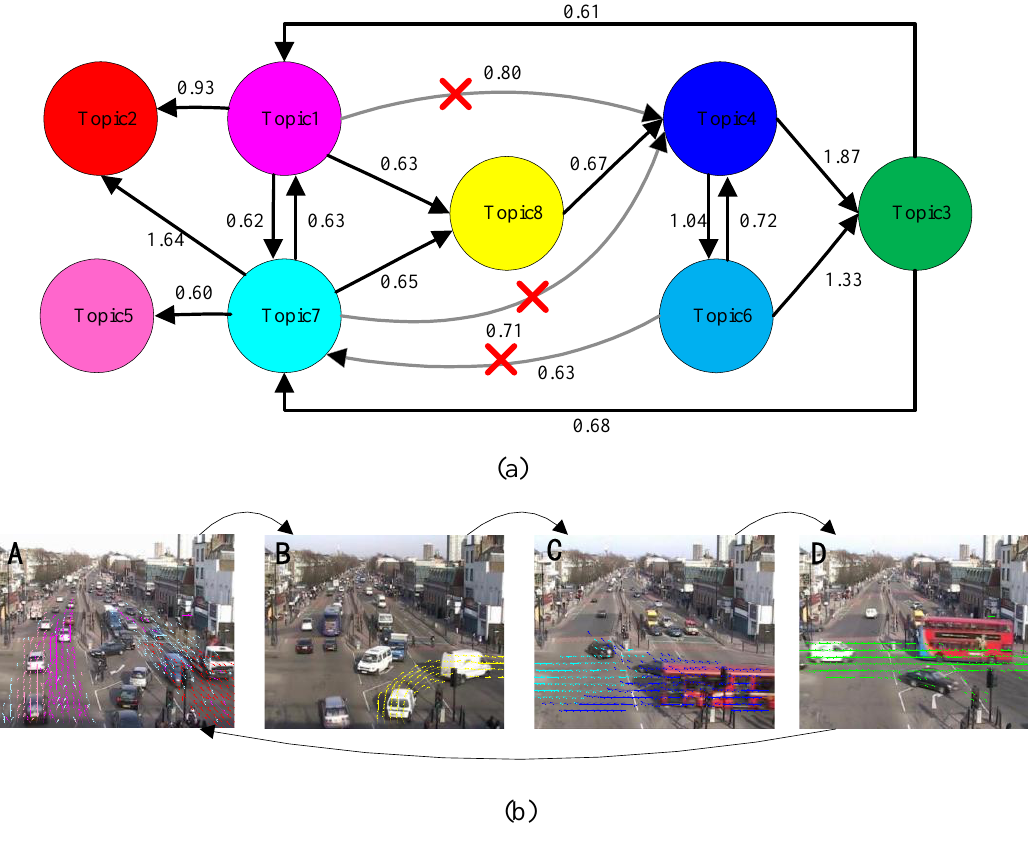
Figure 9. Granger causality approach applied to the intersection dataset. ( a ) Top: visualization of the temporal causal analysis. The connection between topic 6 and topic 7 is spurious because of the mediated influence from topic 3. Similarly, the connections between topic1, 7 and 4 are also removed; ( b ) Bottom: a scene with traffic lights. Four states are automatically